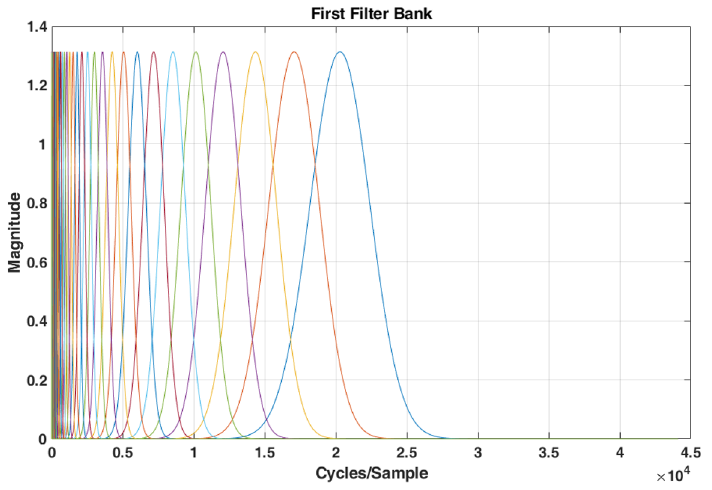
Figure 2. The frequency response of a typical wavelet filter bank with N =